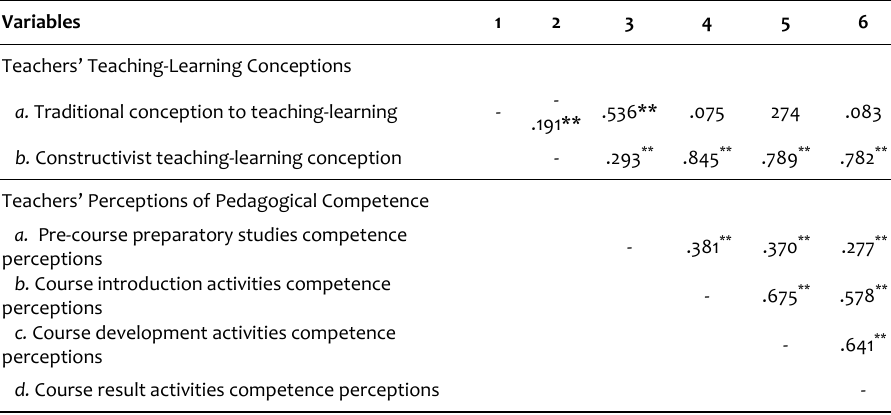
Table 2: Correlation Matrix Between Research